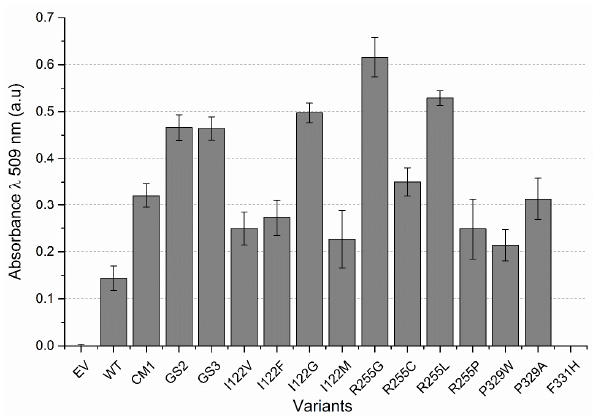
Figure 5. Comparison of 2,3-dihydrobenzo-1,4-dioxin-5-ol and 2,3-dihydrobenzo-1,4-dioxin-6-ol formation by the colorimetric 4-aminoantipyrine (4-AAP) assay ( λ 509 nm). Results show the best-performing P450 BM3 from SSM at the positions 122, 255, 329, and 331. Error bars represent one SD of the mean from seven replicates. CM1 (R255P / P329H), GS2 (R255S / P329H / F331L), and GS3 (I122V / R255S / P329H / F331L). EV—negative lysate control.